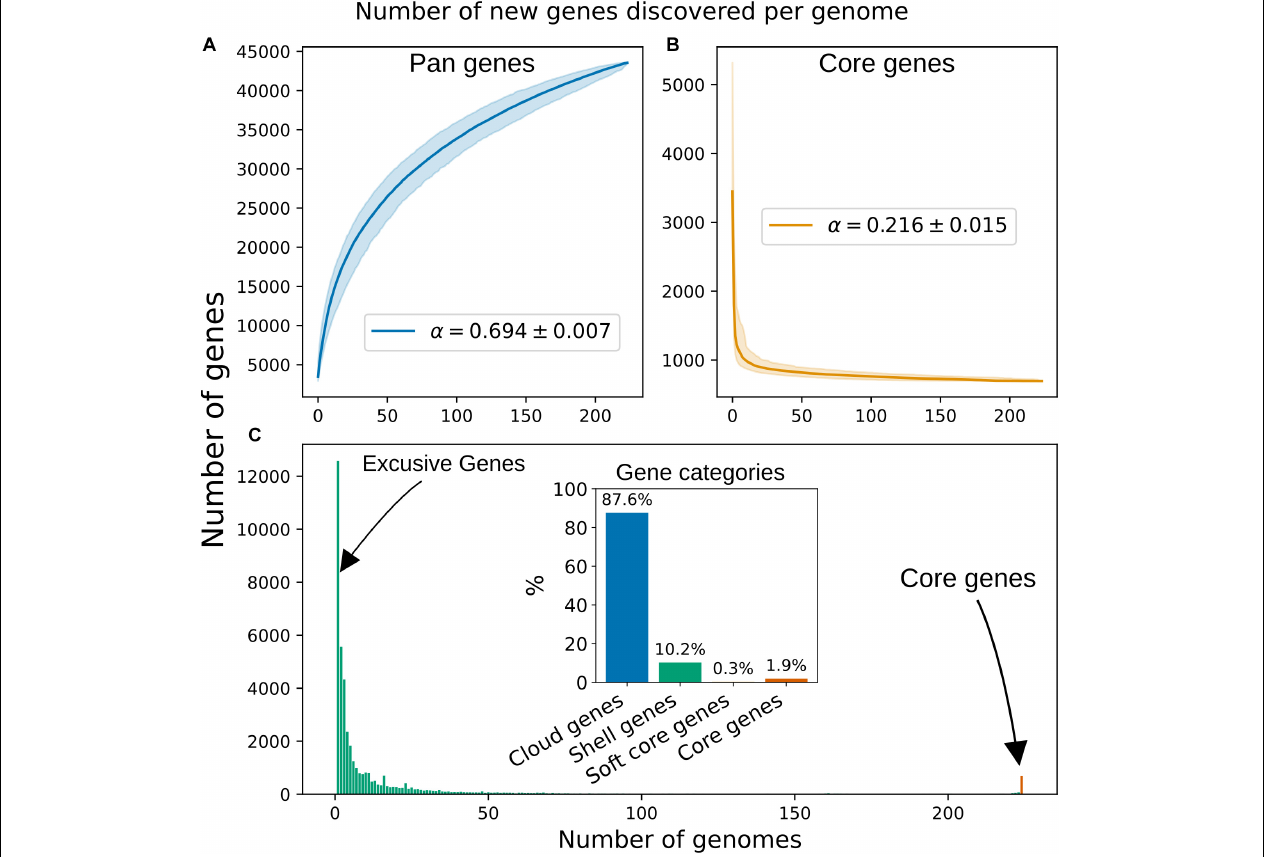
FIGURE 2 | Rarefaction curves for “pan” (A) and “core” (B) genes. The curves were fitted to median values of 1,000 iterations following the Power Law previously described (Tettelin et al., 2008). The Shadows indicate 95% confidence intervals. (C) Distribution of the 43545 pan genes among the 224 genomes of the Blautia dataset. The bar representing the core genes is highlighted with red color. Inset: Percentages for each gene category in the pangenome, see Table 2 for definitions.